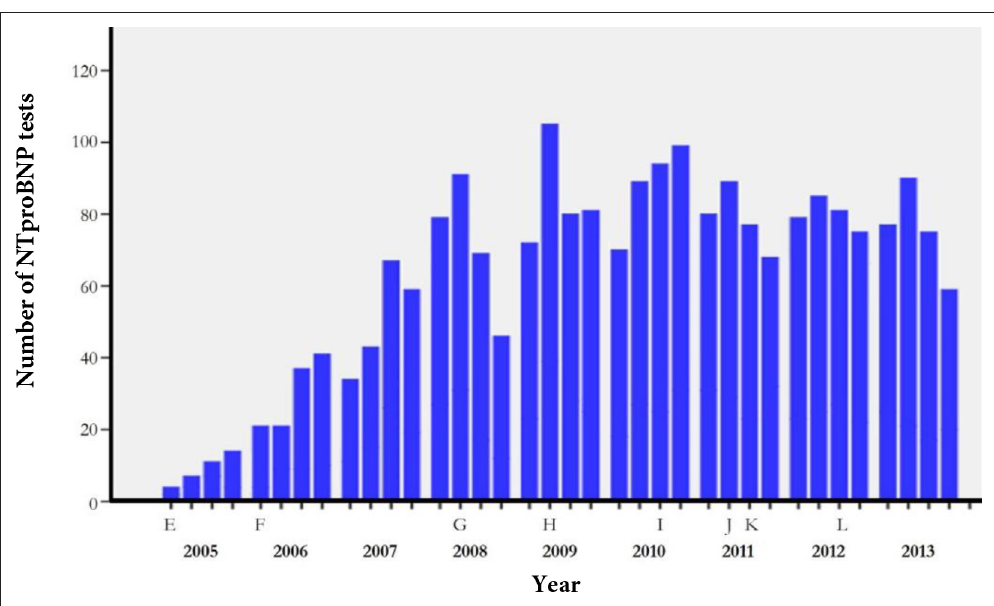
Figure 1 Number of N- terminal B- type natriuretic peptide (NTproBNP) tests as was ordered per quarter of